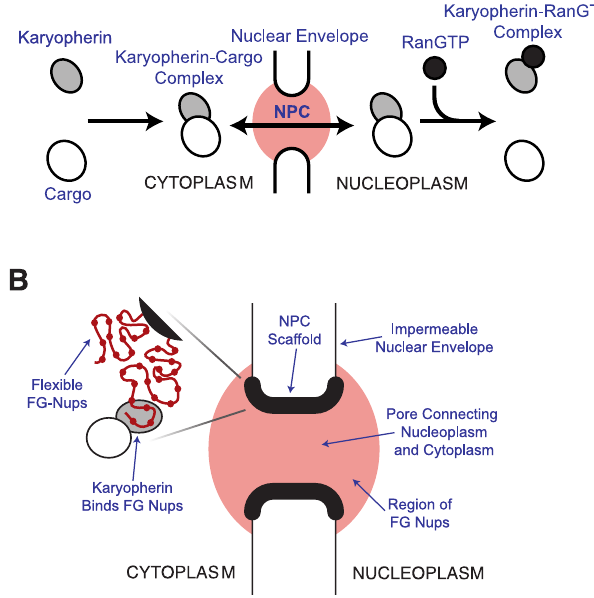
Figure 1. Main Features of the NPC and of Nuclear Import (A) Schematic of the nuclear import process. The karyopherins bind the cargo in the cytoplasm and transport it to the nucleus, where the cargo is released by RanGTP. (B) Schematic of the NPC. The nucleus and the cytoplasm are connected by a channel, which is filled with flexible, mobile filamentous proteins termed FG nups. The karyopherins carrying a cargo enter from the cytoplasm and hop between the binding sites on the FG nups until they either reach the nuclear side of the NPC or return to the cytoplasm.